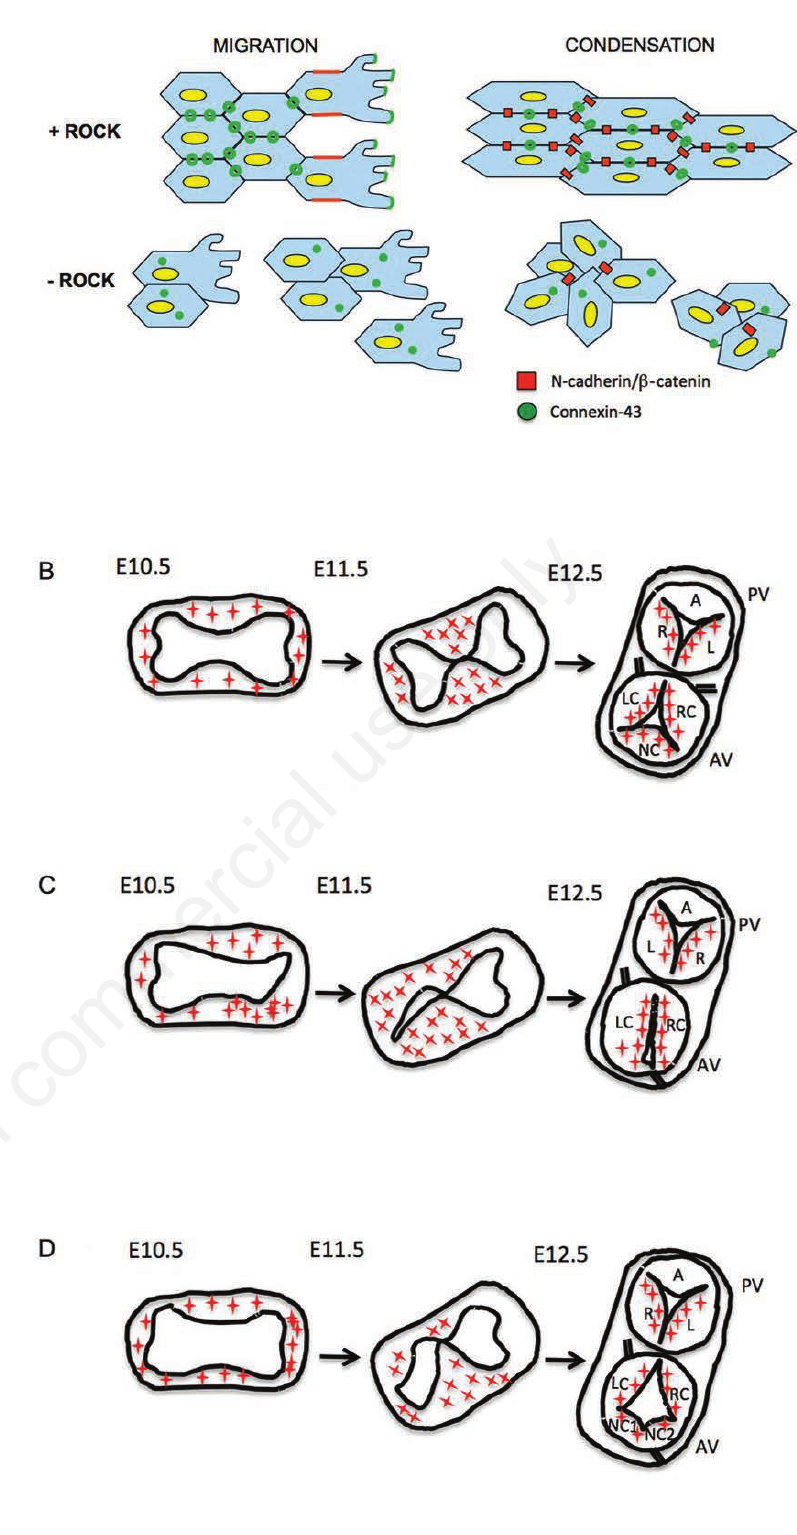
Figure 1. Model for abnormal aortic and pulmonary valve patterning in the developing embryo. A) Abnormalities in cardiac neural crest (CNC) cell adhesion and/or signaling results in disrupted CNC condensation in the outflow cushions. B) Distribution of CNC (red stars) in the outflow tract in normal embryos as the outflow tract septates and tricus- pid aortic and pulmonary valves are formed. C and D) CNC do not condense normally in mutant embryos. As a consequence the valve leaflets are abnormally positioned and irregularly sized yielding a bicuspid aortic phenotype (C) or a quadricuspid phenotype (D). From Philips HM et al. Cardiovasc Res 2013;99:452-60 (Open